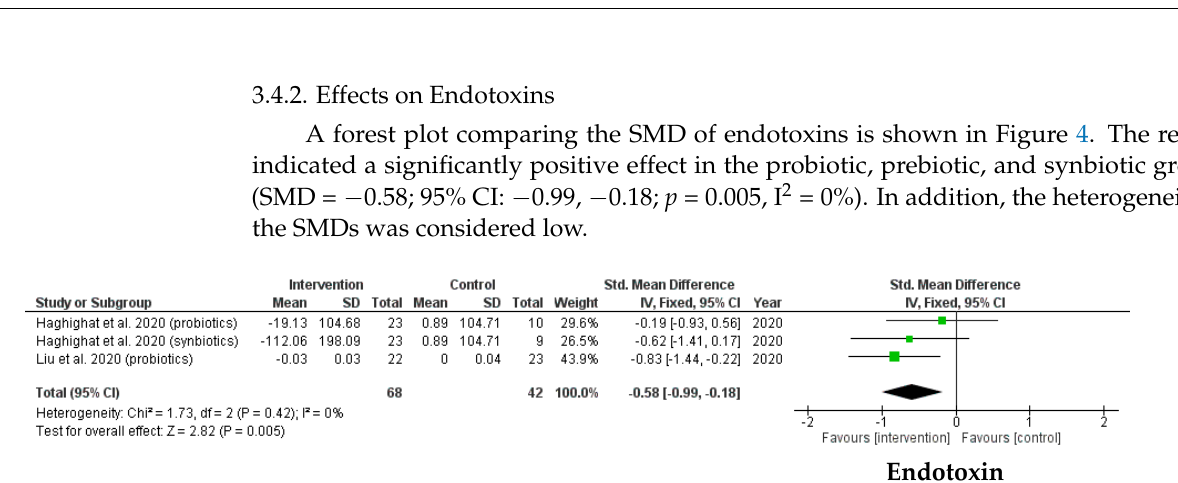
Figure 4. Forest plot for probiotic, prebiotic, and synbiotic effects on endotoxins in hemodialysis patients.